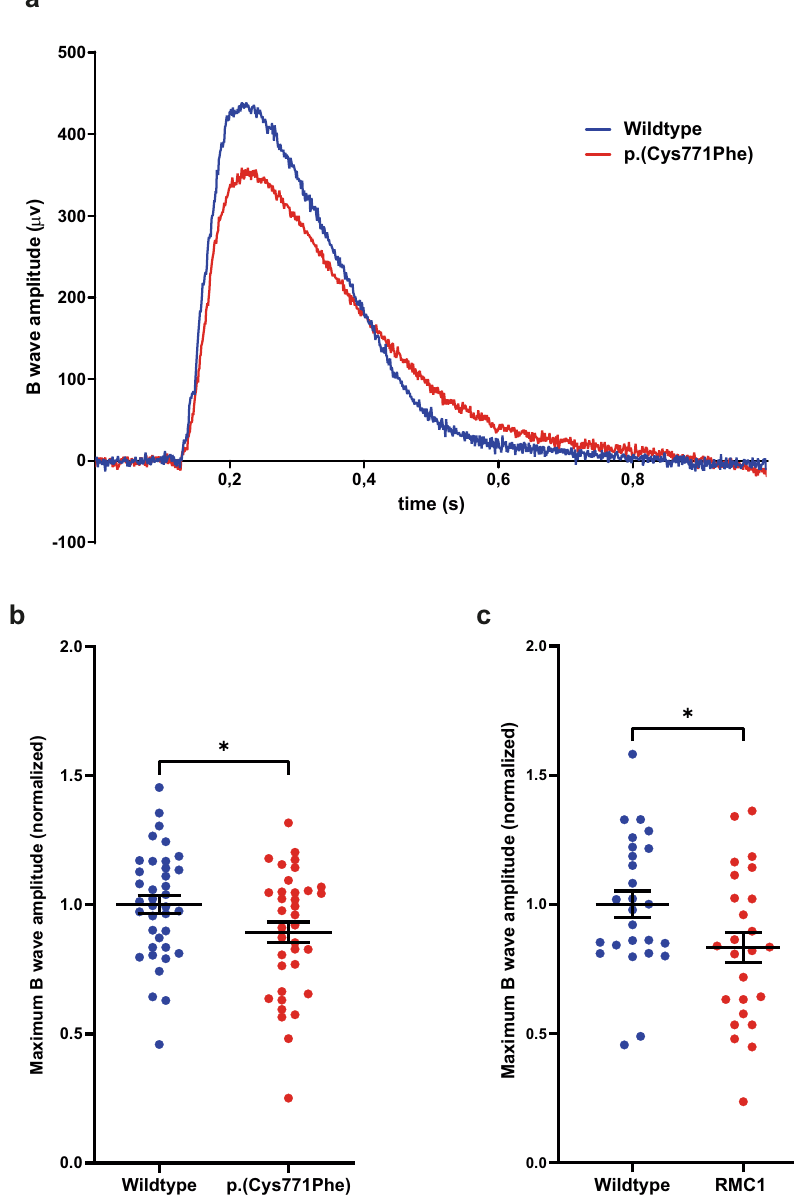
Fig. 5 Electroretinogram recordings show that ush2a p.(Cys771Phe) mutants are vision impaired. a Representative electroretinograms of a p.(Cys771Phe) zebra fi sh and a wildtype sibling at 5 days post-fertilization. b The maximum B wave amplitude was signi fi cantly lower in p.(Cys771Phe) zebra fi sh as compared to wildtype siblings (unpaired t test). The average wildtype amplitude was normalized to 1. Each datapoint corresponds to recordings from an individual larvae (mean ± SEM). * p : 0.0445. c A comparative analysis of ush2a rmc1 knock-out larvae and age- and strain-matched wildtype larvae was shown to result in a similar and signi fi cant decrease in maximum B wave amplitude. Again, the average wildtype amplitude was normalized to 1. Each datapoint corresponds to recordings from an individual larvae (unpaired t test, mean ± SEM). * p : p.(Cys771Phe) larvae as compared to wildtype larvae (unpaired Students t test (two-tailed); p : 0.0445; t: 2.045; df: 72), which is indicative of an impaired visual function (Fig. 5b). ERG responses were also recorded for ush2a rmc1 knock-out larvae (5 dpf; n = 25 from three biological replicates) and age- and strain-matched wildtype siblings ( n = 26 from three biological replicates). In the knock-out model a similar signi fi cant decrease in maximum B wave amplitude of ~15% compared to age- and strain-matched wildtype larvae was observed (unpaired Student ’ s t test (two- tailed); p : 0.0345; t: 2.175, df: 49) (Fig. 5c).